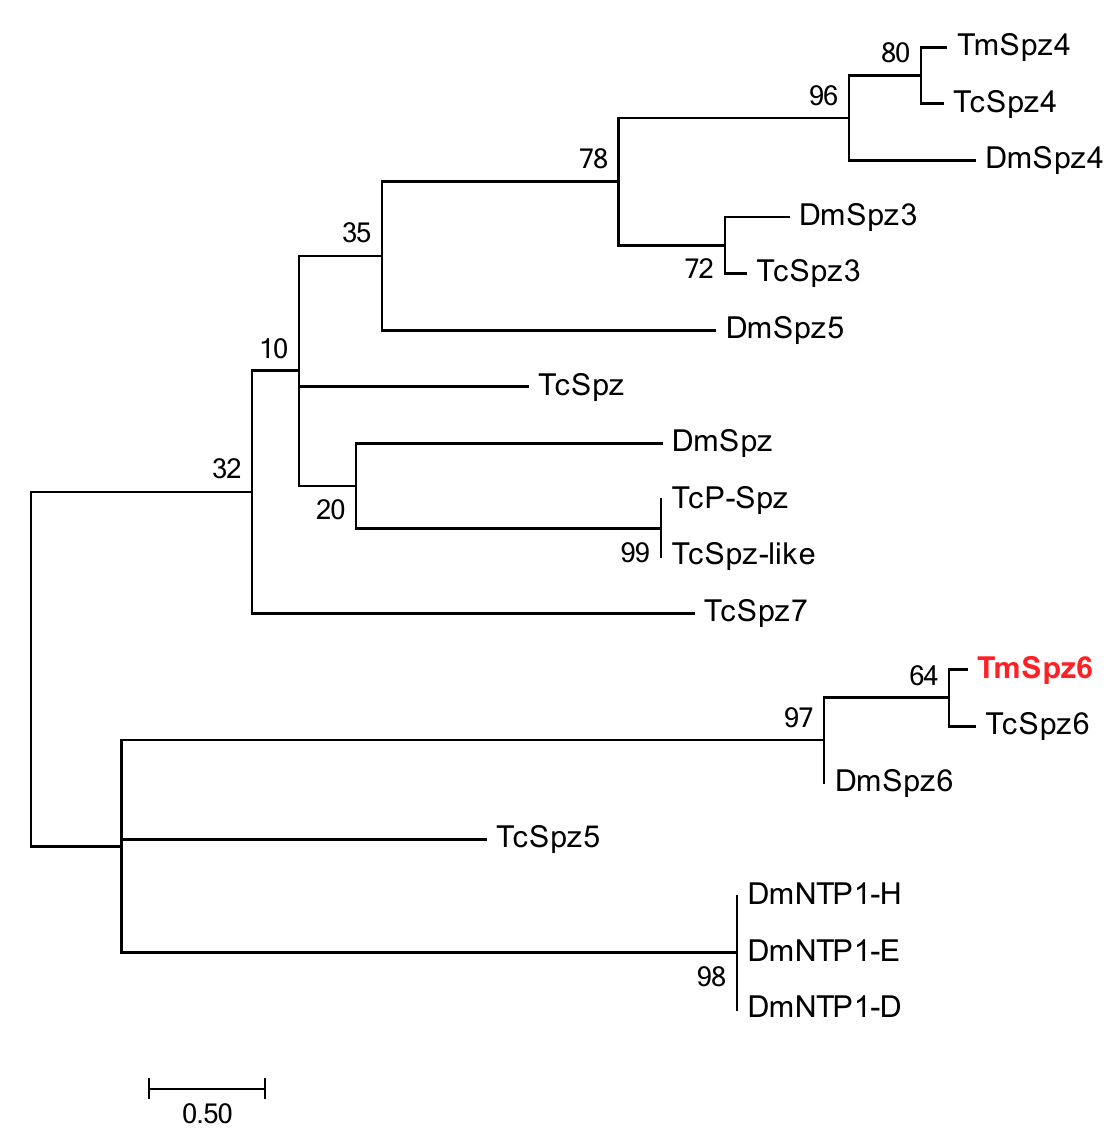
Figure 2. Molecular phylogenetic analysis of insect Spz6 homologs. Phylogenetic analyses of Tm Spz6 homologues were performed using ClustalX2, and the phylogenic tree was constructed with MEGA7 using the maximum likelihood method and 1000 bootstrapped replications. The following protein sequences were used to construct the phylogenetic tree. Dm Spz4, Drosophila melanogaster spätzle 4